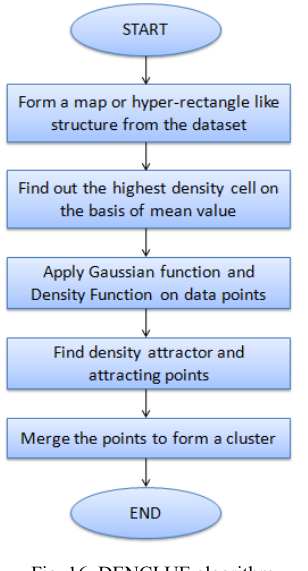
Fig. 16. DENCLUE algorithm.